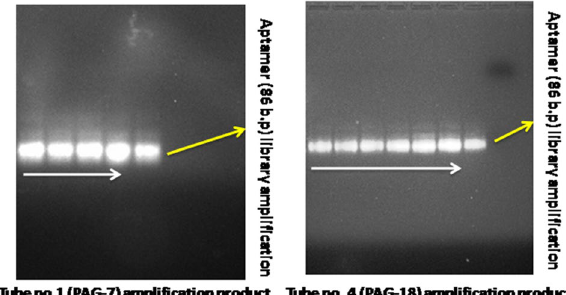
Figure 3. Agarose gel run of amplified aptamers, selected against PAG proteins.